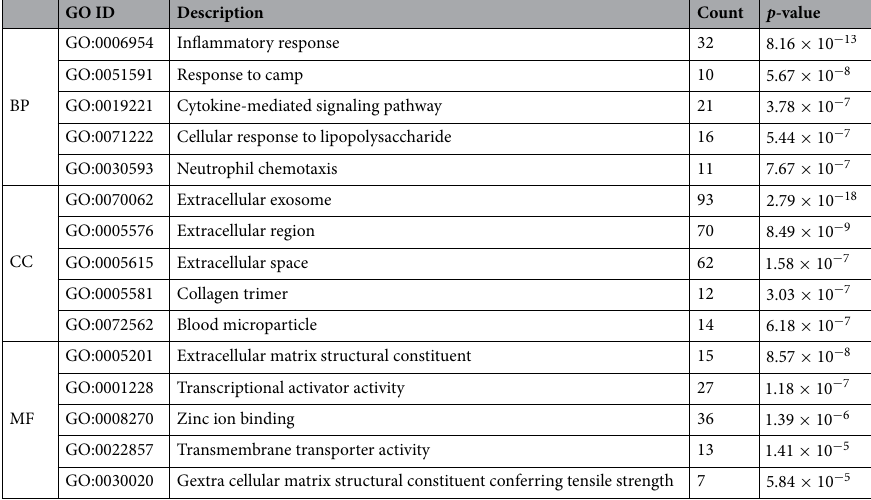
Table 1. GO analysis of DEGs in biological process, cellular component, and molecular function. Top five items were selected based on p -value. GO gene ontology, BP biological process, CC cellular component, MF molecular function.